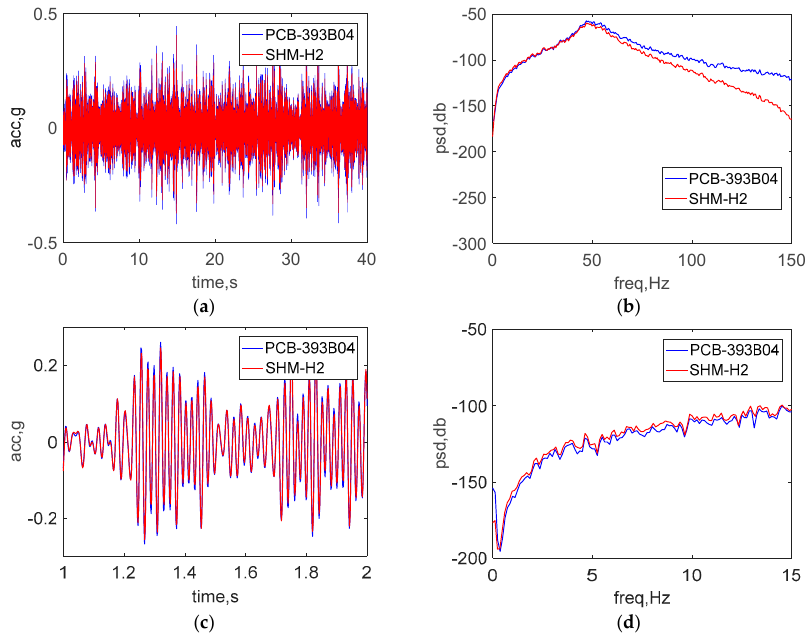
Figure 9. Shaking table test results: ( a ) time history data ( b ) PSD data ( c ) zoomed view of time history data ( d ) zoomed view of low-frequency PSD data.